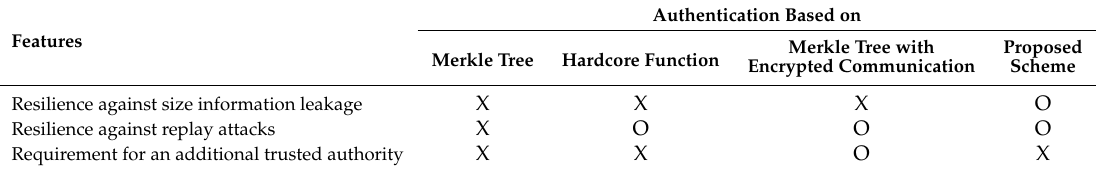
Table 6. Average computation time (ms) for Merkle tree-based encrypted authentication by data size (standard deviation in parentheses).